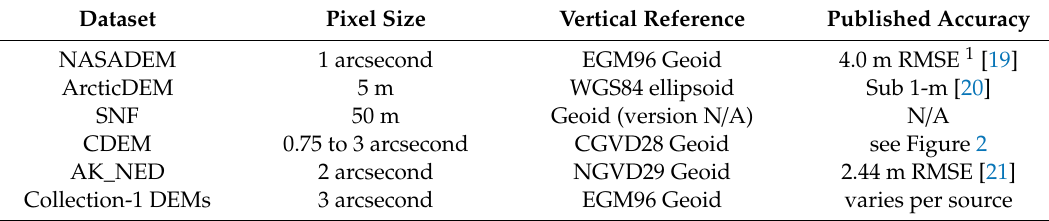
Table 2. Original specifications of evaluated